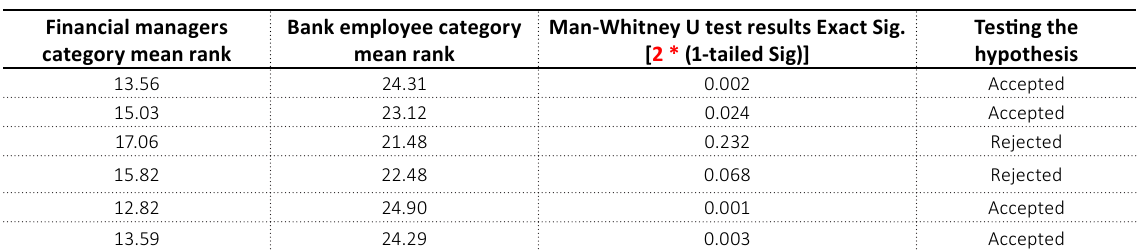
Table 11. Mann-Whitney U